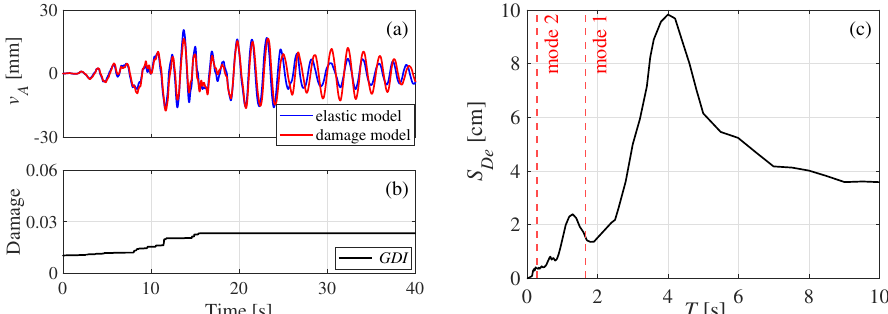
Figure 19. Earthquake SPM 2 station: ( a ) elastic and damage responses of the equivalent pier, ( b ) evolution of the GDI , ( c ) elastic displacement spectrum.